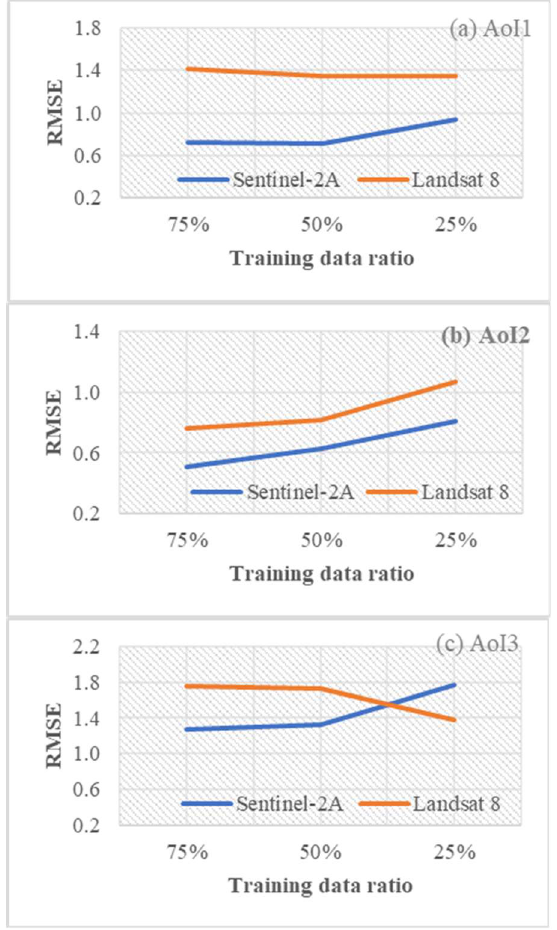
Figure 3. The graphs depicting the RMSE values for each AoI with various training ratios.